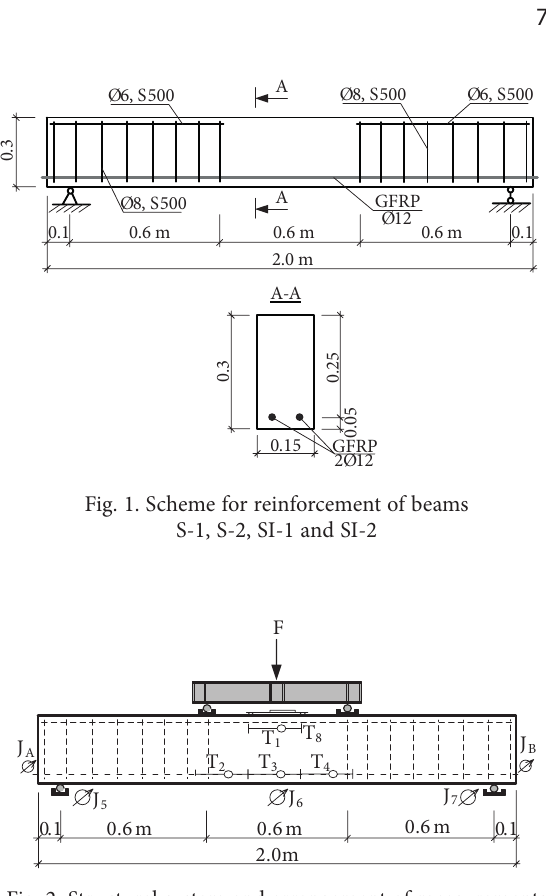
Fig. 2. Structural system and arrangement of